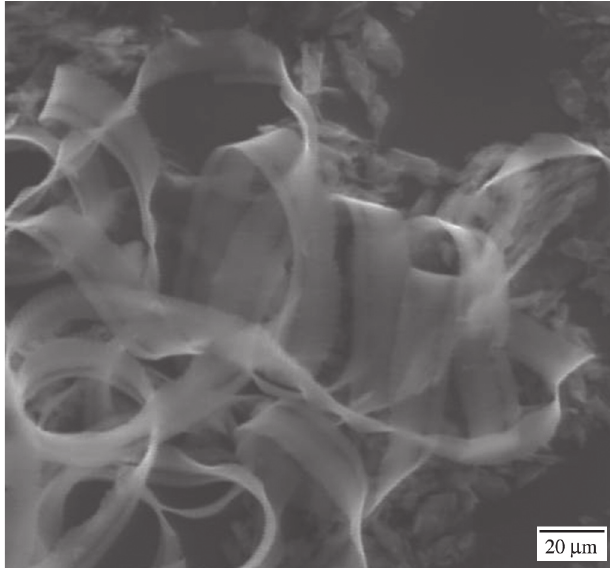
Figure 3. Scanning electron micrography of a chip left on the surface of the machined silicon sample in the ductile regime. The ribbon-like chips indicate a plastic flow characteristic of ductile mode.